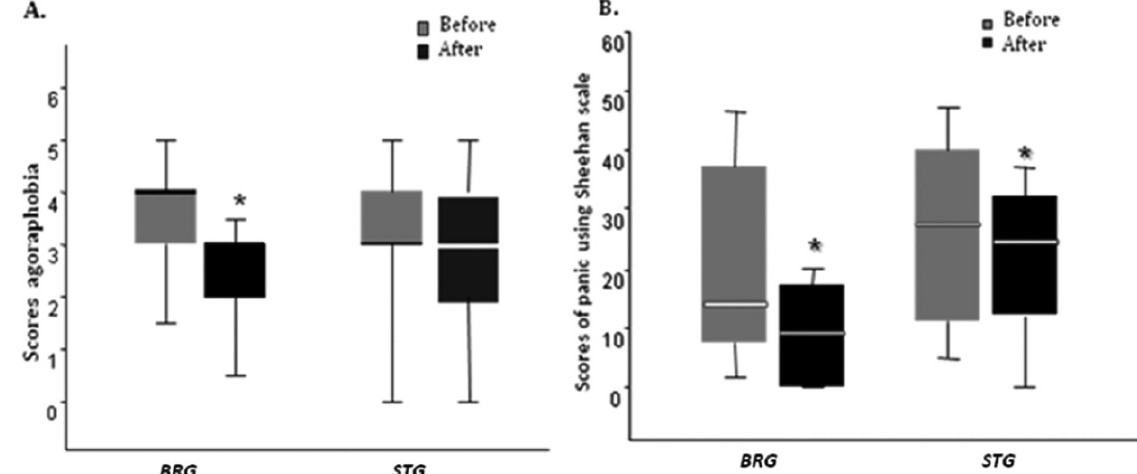
Figure 2 - At the end of the study, the scores for agoraphobia and panic disorder symptoms (Figure 2A) were significantly reduced only in the BRG group (p , 0.05). According to the Sheehan scale, panic scores (Figure 2B), were significantly decreased for both the BRG and